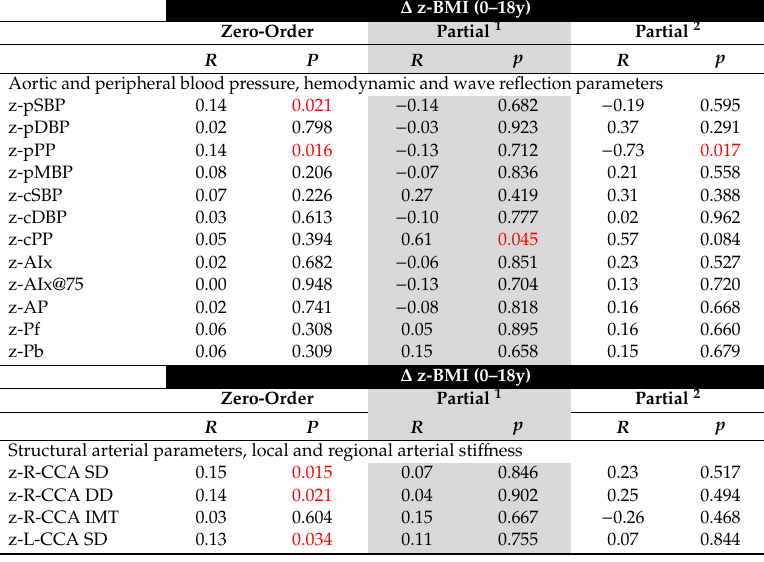
Structural arterial parameters, local and regional arterial sti ff ness z-R-CCA